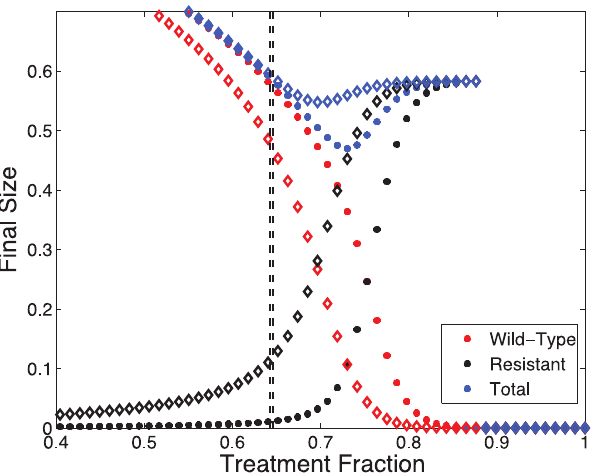
Figure 7. Final Sizes vs. relative transmissibility for r ~ r (cid:3) and r ~ r min . The figure shows the effectiveness of r (cid:3) and r min vs. the relative transmissibility. For any value of w , r (cid:3) is more effective than r min at avoiding the spread of resistance in the population (black diamond vs. black dashed curves). However, r min is more efficacious at reducing the overall epidemic (blue dashed vs. blue diamond). Solid line corresponds to r ~ 0 . Other parameters: b u ~ 0 : 6, c ~ 0 : 002 :